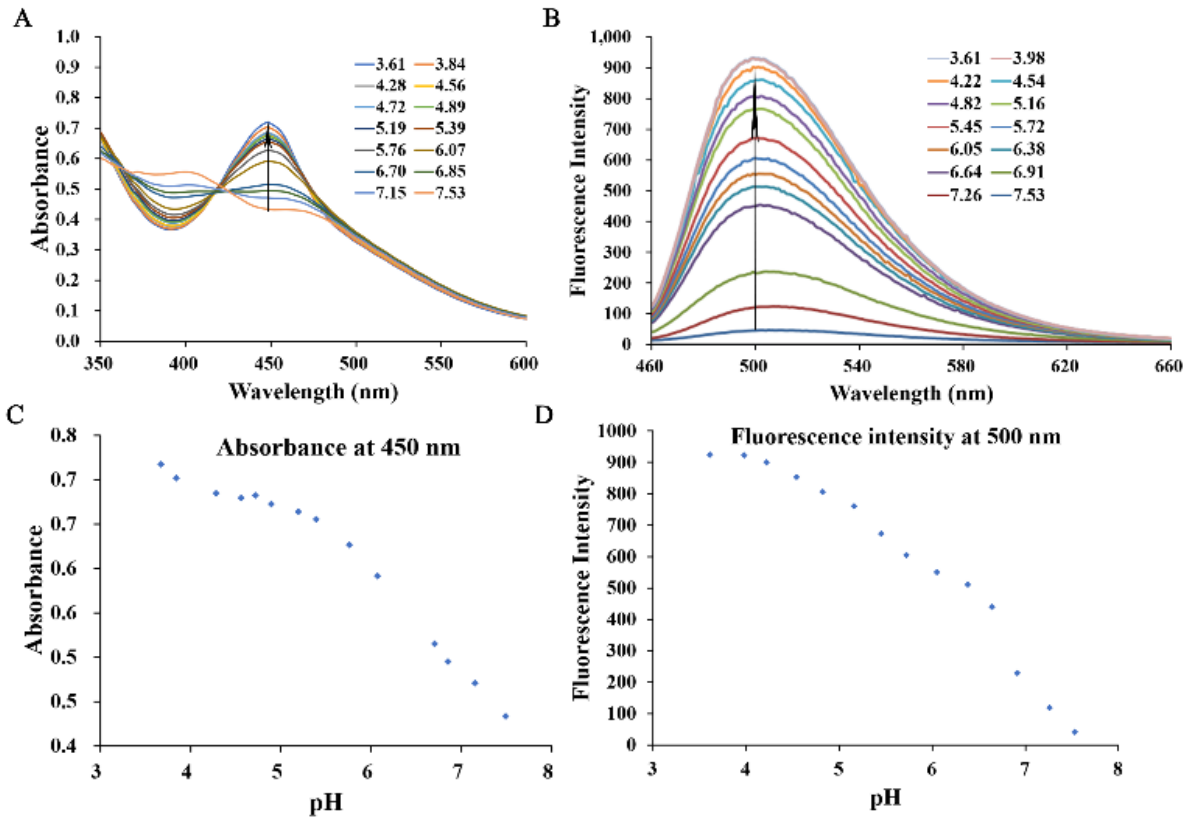
Figure 2. Spectra of normalized absorption ( A ) and fluorescence emission ( B ) for H6AQ (10 µ M) at various pH values (3.61–7.53) in aqueous 10% ( v / v ) DMSO. Quantitative analysis of the absorption ( C ) and emission maximum ( D ) of H6AQ at various pH values (3.61–7.53) in aqueous 10% ( v / v ) DMSO ( λ ex = 450 nm).